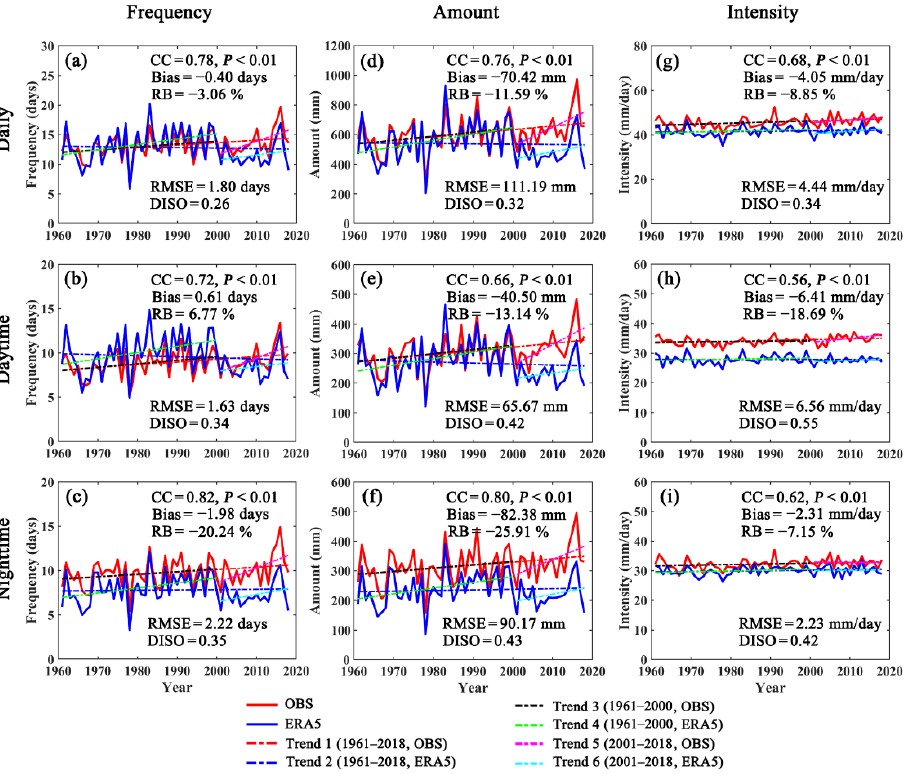
Figure 6. Time series of the annual extreme precipitation frequency ( a – c ), amount ( d – f ), and intensity ( g – i ) in the observational stations (red) and their corresponding ERA5 grid points (blue) reanalysis data at the daily, daytime, and nighttime scales (left, middle, and right columns, respectively). Table 2. Trends of annual extreme precipitation frequency, amount, and intensity from observational stations and their corresponding ERA5 grid points, respectively, at the daily, daytime, and nighttime scales.